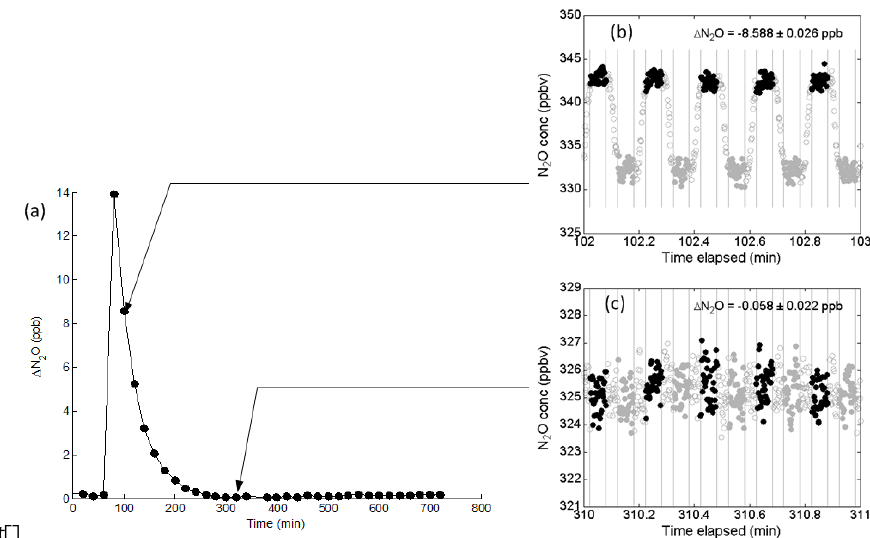
Fig. 4. Test of FS-NOMAS accuracy and resolution using “spiked” barrel approach. (a) Difference in N 2 O mole fraction ( 1 N 2 O) between spiked and unspiked barrels. Spiking of 1250nL of pure N 2 O into a 60L barrel occurred at 100min. Time series of 10Hz N 2 O determinations at 102min (b) and 310min (c) , where solid points represent N 2 O measured at heights of 0.5 ( z 1 , black circles) and 1.0m ( z 2 , grey circles). Data affected by valve switching between z 1 and z 2 (open circles) are